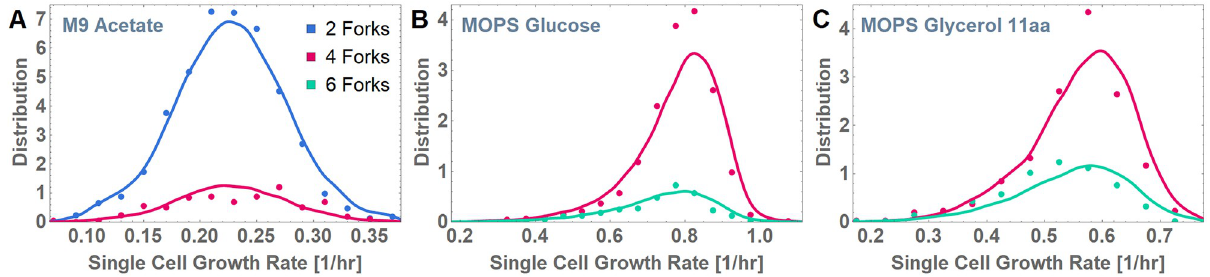
Fig 5. Comparing model predictions to experimental data. Model simulations (dashed lines) are compared with the experimentally obtained distributions (solid lines) of number of forks after initiation at different single-cell growth rates for the following growth conditions: (A) M9 acetate, (B) MOPS glucose, and (C) MOPS glycerol 11aa. Colors represent different number of forks after initiation: 2 (blue), 4 (magenta), and 6 (teal). There is a close match between model predictions and experimental data, indicating that the presence of different numbers of forks and both single and multifork replication within the same growth condition is purely a consequence of the inherent stochasticity in the 3 time periods governing the replication cycle (the C period, the inter-initiation period, and the time to division), each of which depends solely on single-cell growth rate for a given growth condition.